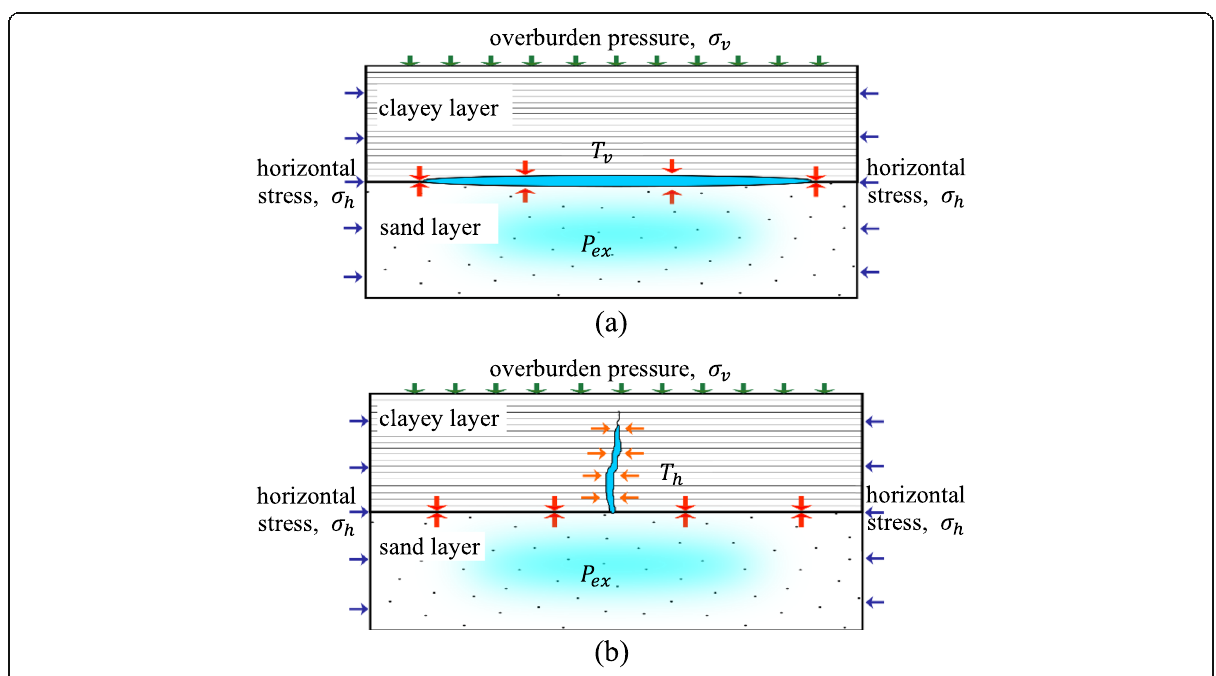
Fig. 10 Schematic cross-section of a sedimentary layer: a Horizontal crack (e.g., water film formation) and b vertical